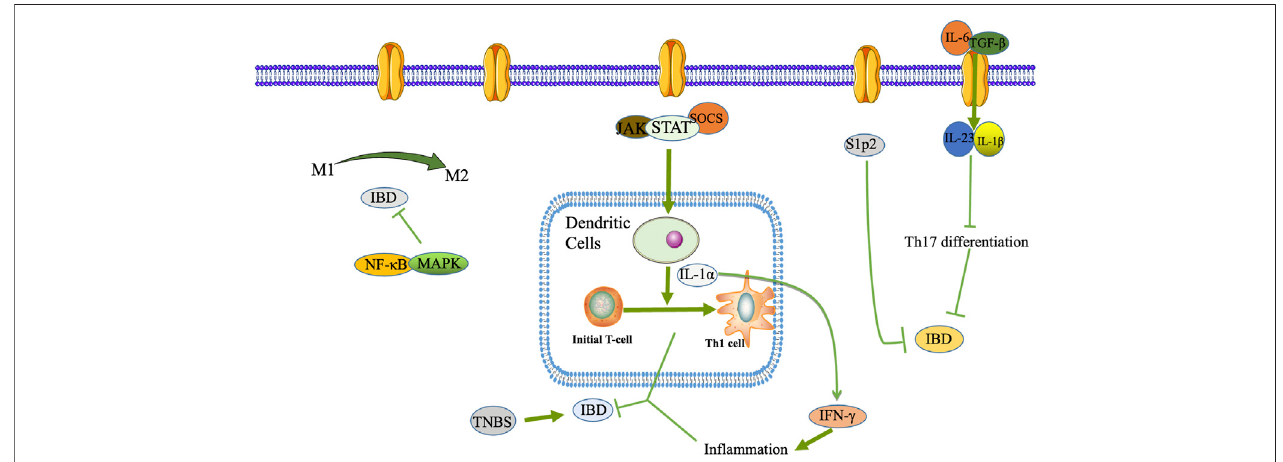
FIGURE 1 | DCs, macrophages, T lymphocyte differentiation and Th17/Treg transformation play a role in the pathogenesis of